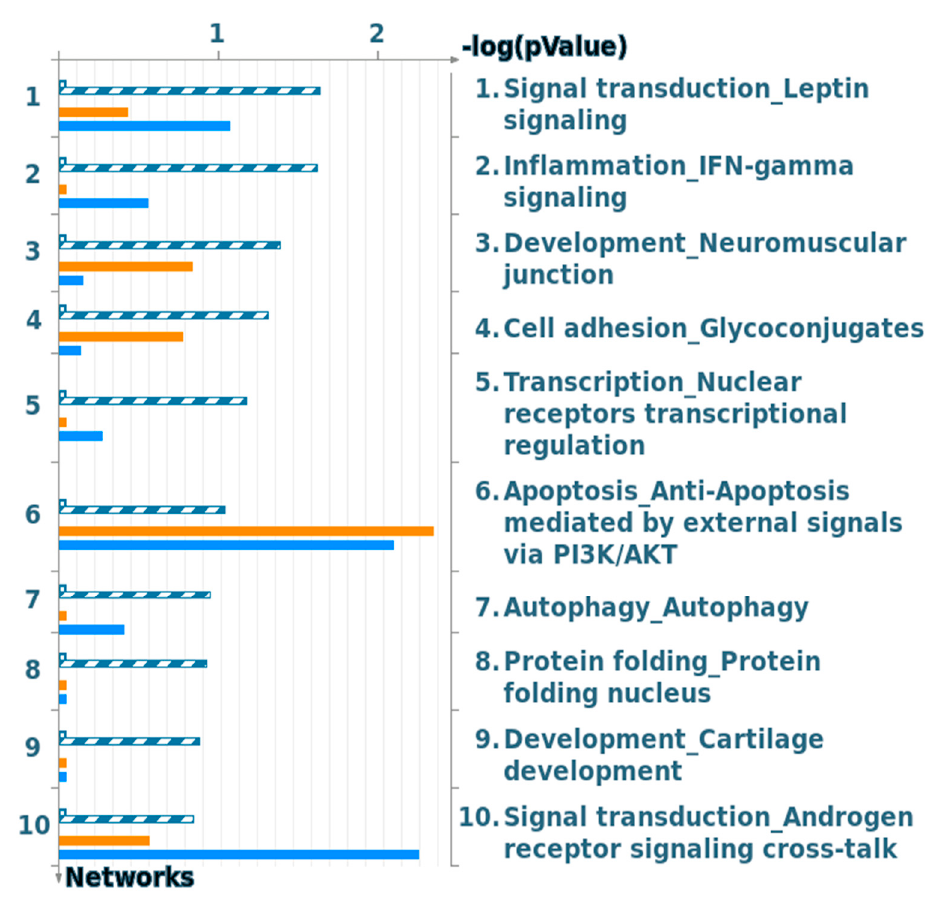
Figure 8. Process and biological networks. The content of these cellular and molecular processes is defined and annotated by Clarivate Analytics scientists. Each process represents a pre-set network of protein interactions characteristic for the process.